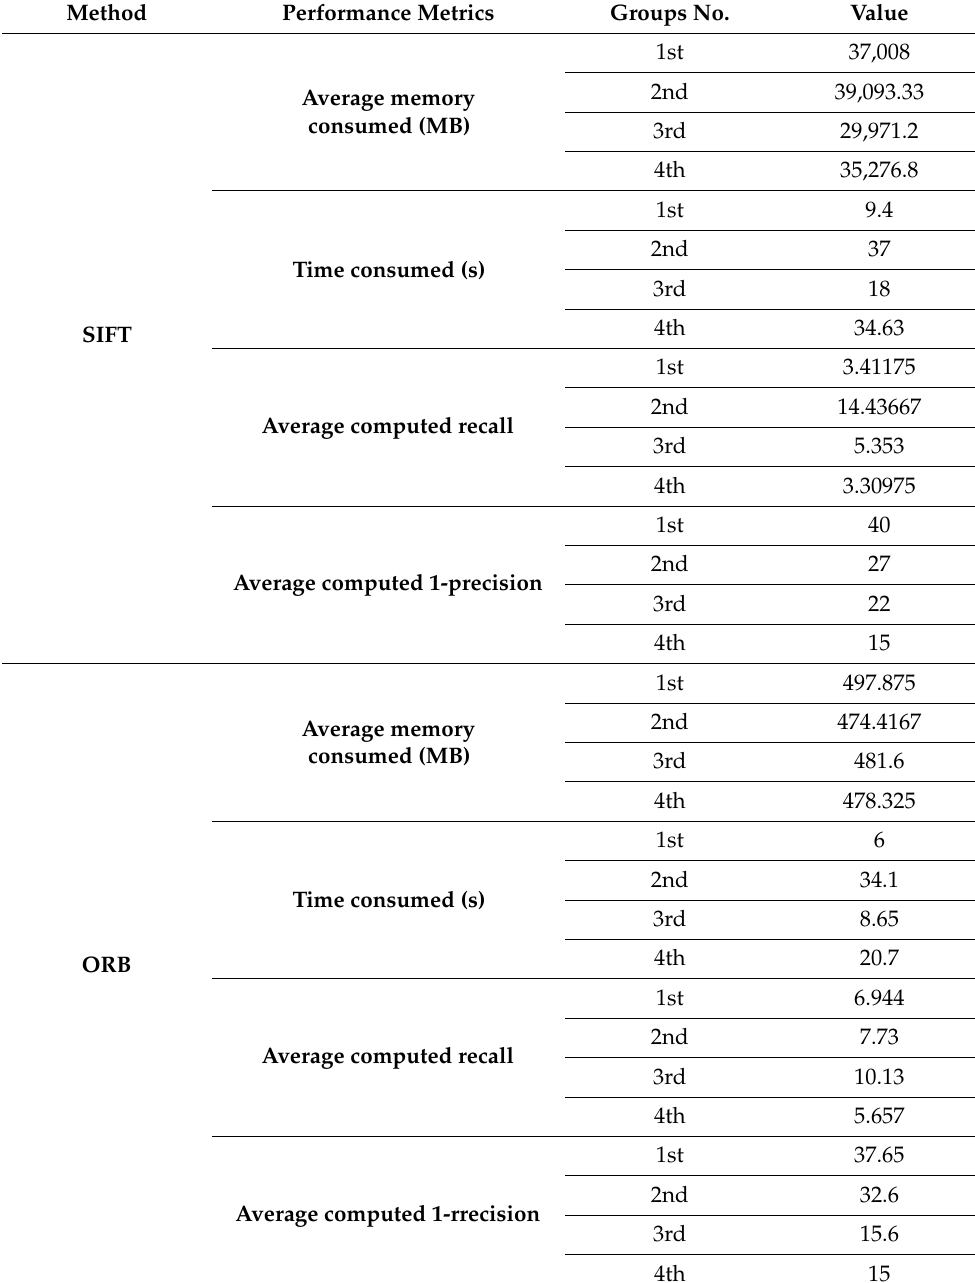
Table 2. Computed performance metrics for methods based on handcrafted features over the four groups of the TU Berlin